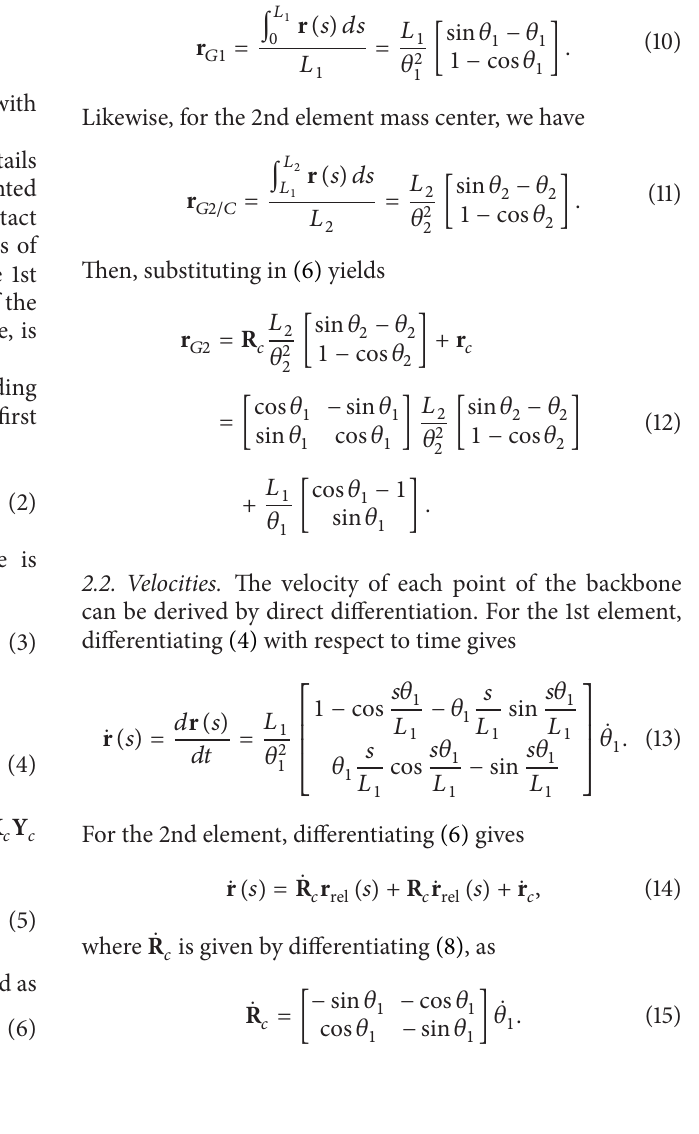
Figure 5: Kinematics of the two circular elements.